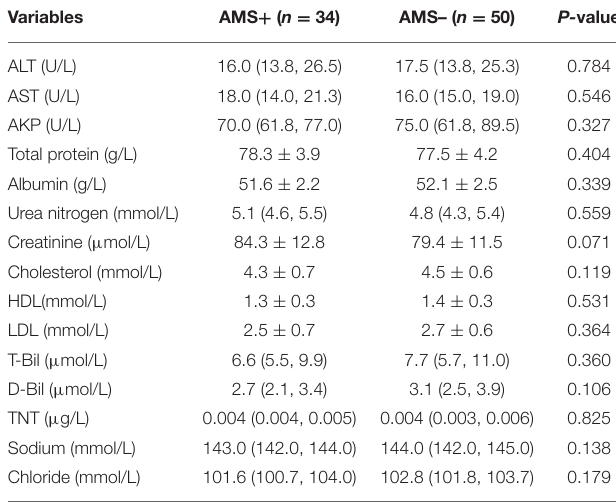
TABLE 5 | Comparison of blood biochemistry at high altitude between two groups of volunteers. Variables